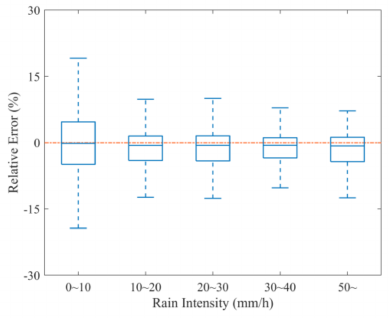
Figure 11. The statistical relative errors between OEL and CMORPH for di ff erent rain intensity